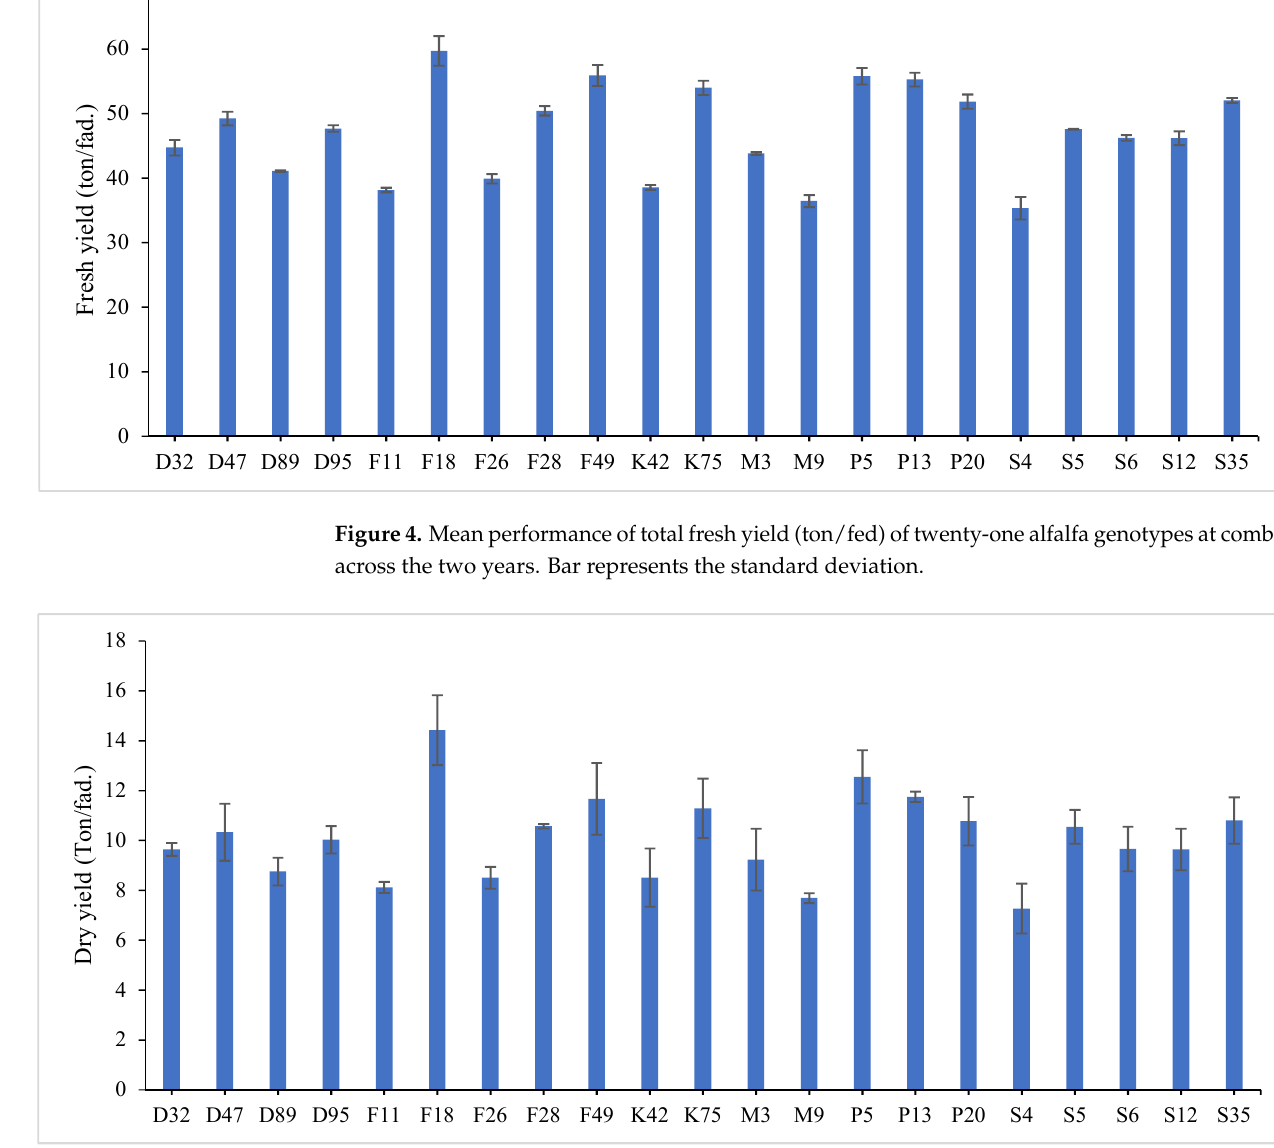
Figure 5. Mean performance of total dry yield (ton/fed) of twenty-one alfalfa genotypes at combined across the two years. Bar represents the standard deviation.